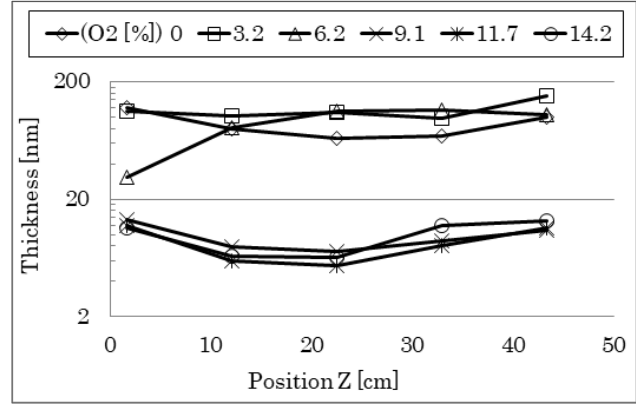
Figure 7. Distributions of the film thickness along the axial position at different fraction of O 2 (%) in the case with the Al outer anode.